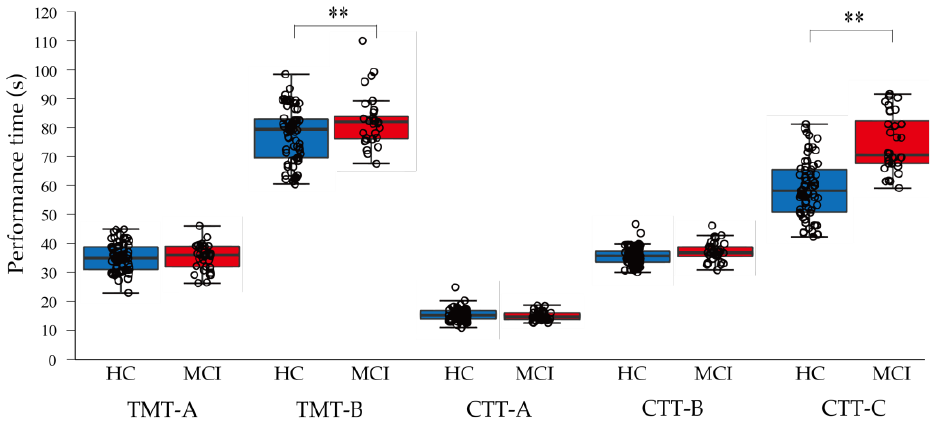
Figure 4. Comparison of each neuropsychological test between the HC and MCI groups. The vertical axis indicates the time (s) to complete each neuropsychological test. HC, healthy control; MCI, mild cognitive impairment; TMT-A, Trail Making Test Part A; TMT-B, Trail Making Test Part B; CCT, Cognitive Composition Test. **: p < 0.01.